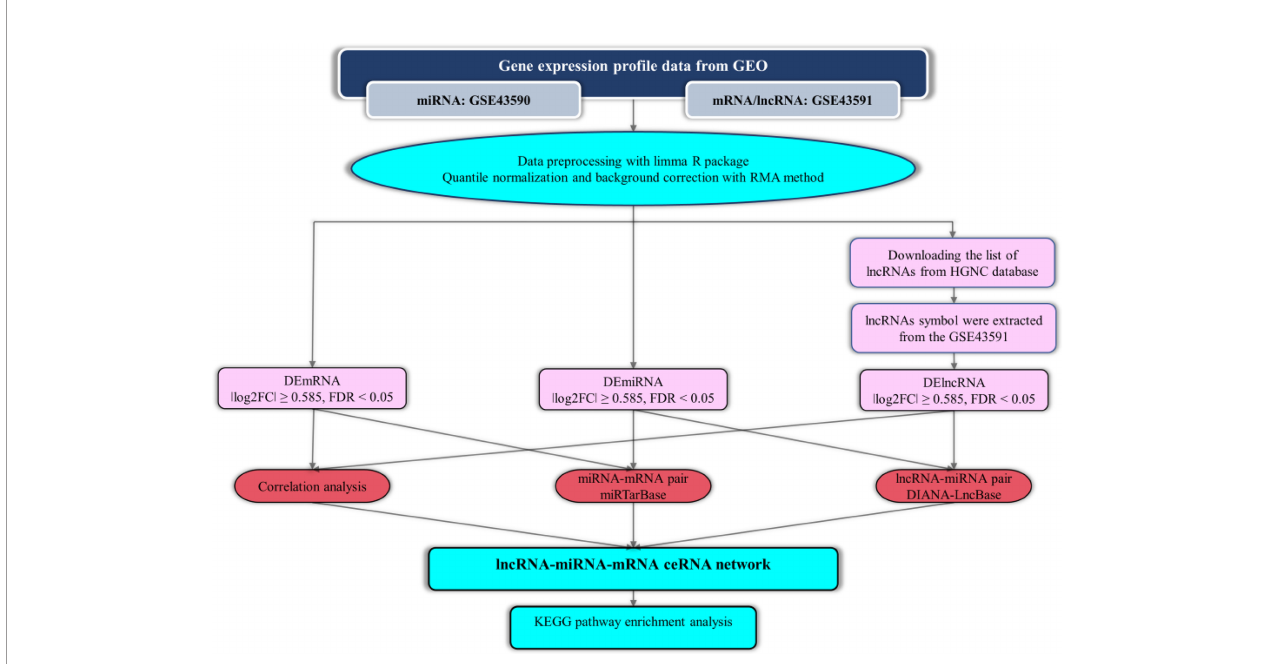
FIGURE 1 | Flow chart of bioinformatics